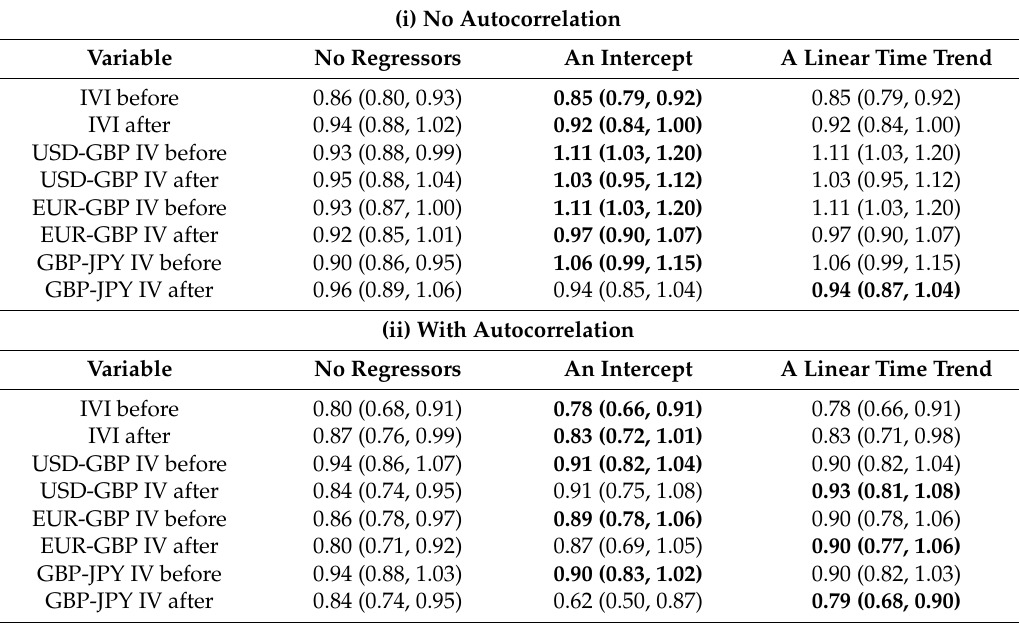
Table 3. Estimates of d for the subsamples before and after the Brexit referendum based on parametric